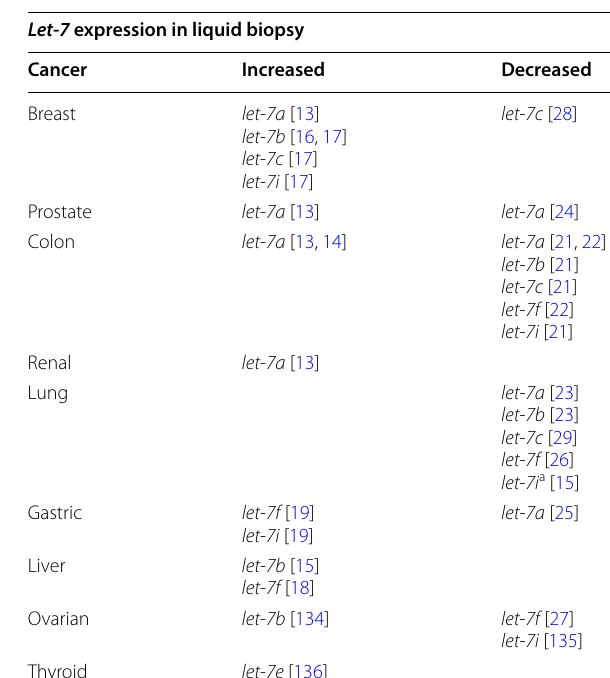
Table 1 Levels of serum let ‑ 7 relative to normal control in patients with different types of